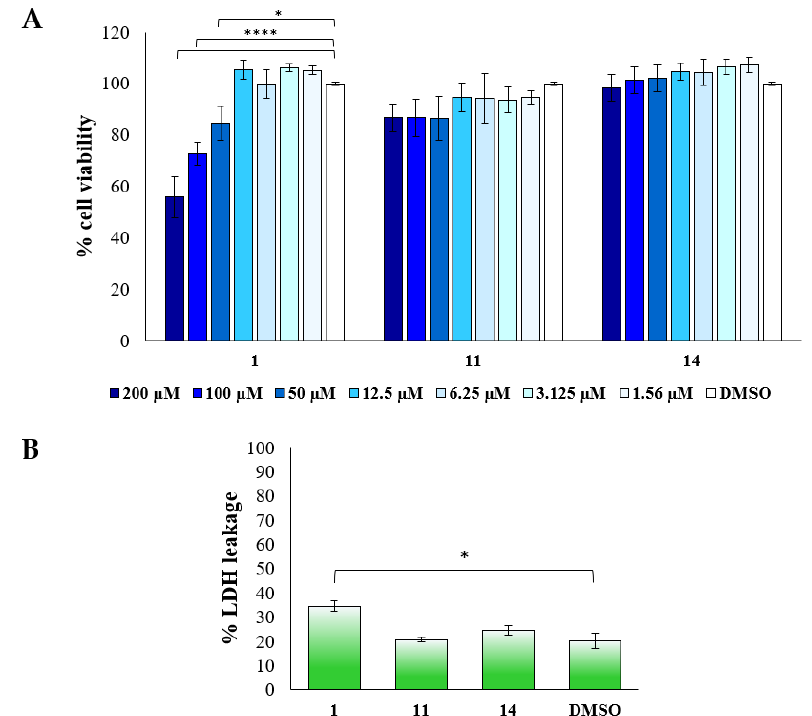
Figure 6. ( A ) MTT assay on HGFs exposed to compounds 1 , 11 , and 14 , all administered at doses ranging from 1.56 to 200 µM for 48 h. Cell viability was measured by MTT assay and normalized to control cells treated with DMSO (0.15% as final concentration). The most representative of three separate experiments is shown. Data are the mean ± standard deviation. **** vs. DMSO p < 0.0001; * vs. DMSO p < 0.1. ( B ) Cytotoxicity assay performed on HGFs treated with 1 , 11 , 14 , and control vehicle (DMSO), all administered at 200 µ M for 48 h. LDH leakage is reported as percentage. Data are presented as the mean ± standard deviation of three separate experiments. * vs. DMSO p <